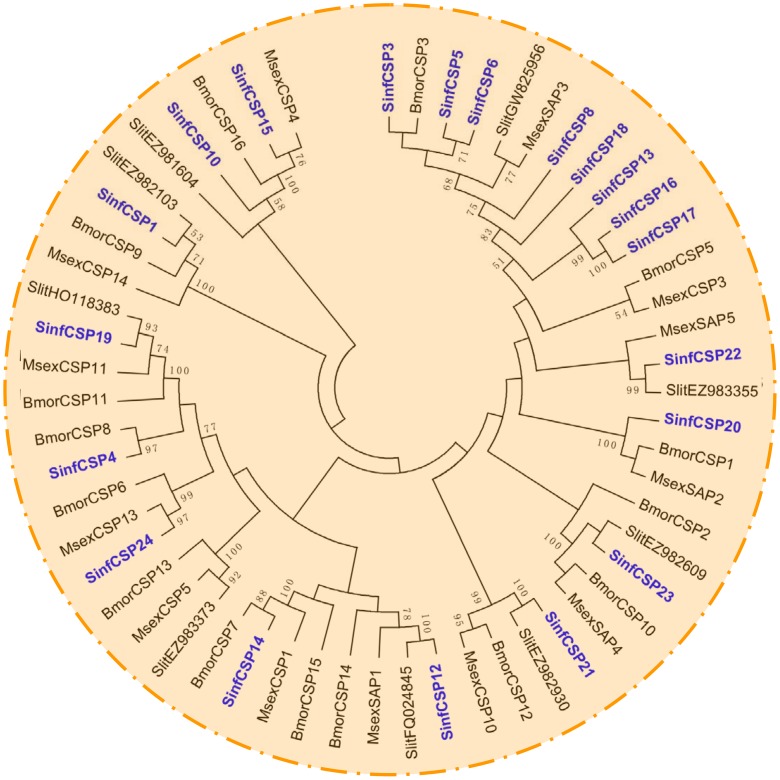
Phylogenetic tree of putative CSPs from S. inferens, M. sexta, S. littoralis and B. mori.The S. inferens translated unigenes are shown in blue. Accession numbers are given in Table S3. The tree was constructed with MEGA5.0, using the neighbour-joining method. Values indicated at the nodes are bootstrap values based on 1000 replicates, and the bootstrap values <50% are not shown. Sinf, Sesamia inferens; Msex, Manduca sexta; Slit, Spodoptera littoralis; Bmor, Bombyx mori.